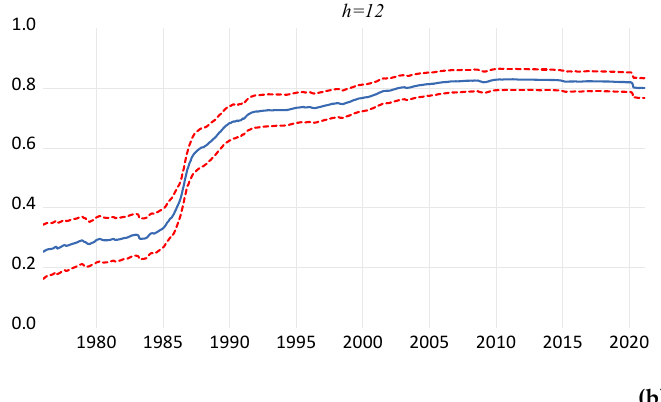
Figure A2. Plot of Recursive Estimate of γ . Note: see note to Table 1. Plots include the recursive estimate of γ (blue line) along with the 95% confidence bands (red dotted lines). ( a ) Time-varying predictability of GS. ( b ) Time-varying predictability of GP.